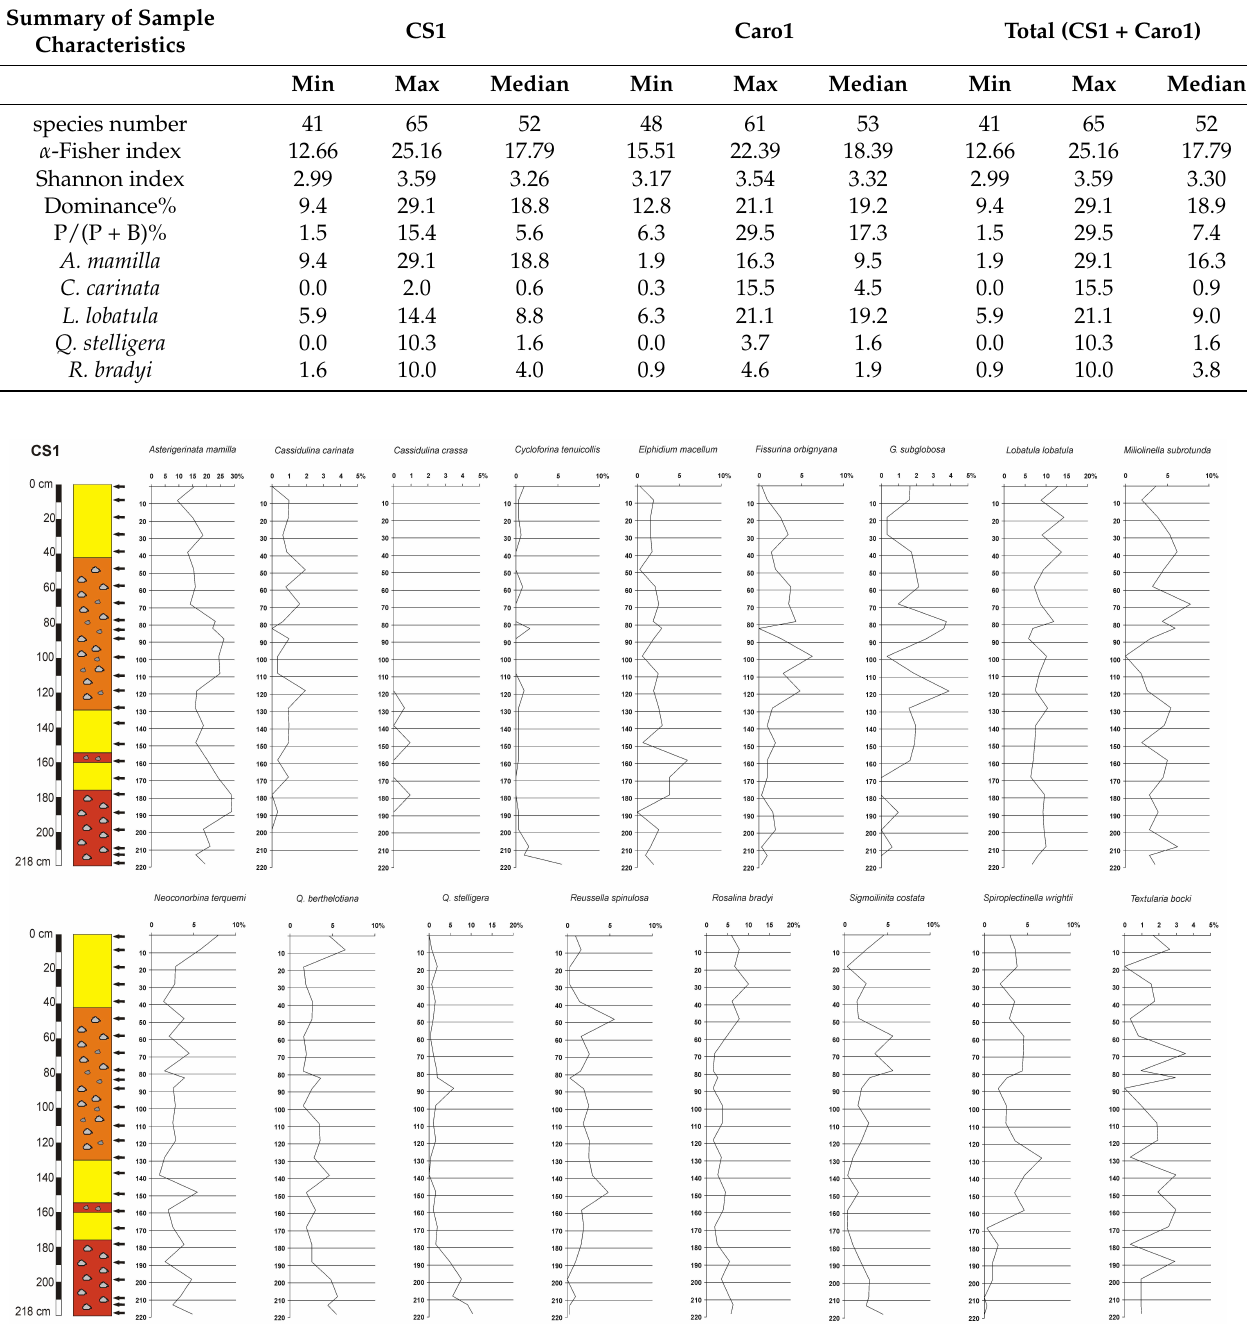
Figure 4. Relative abundance along the core CS1 of 17 benthic foraminiferal species utilized for statistical